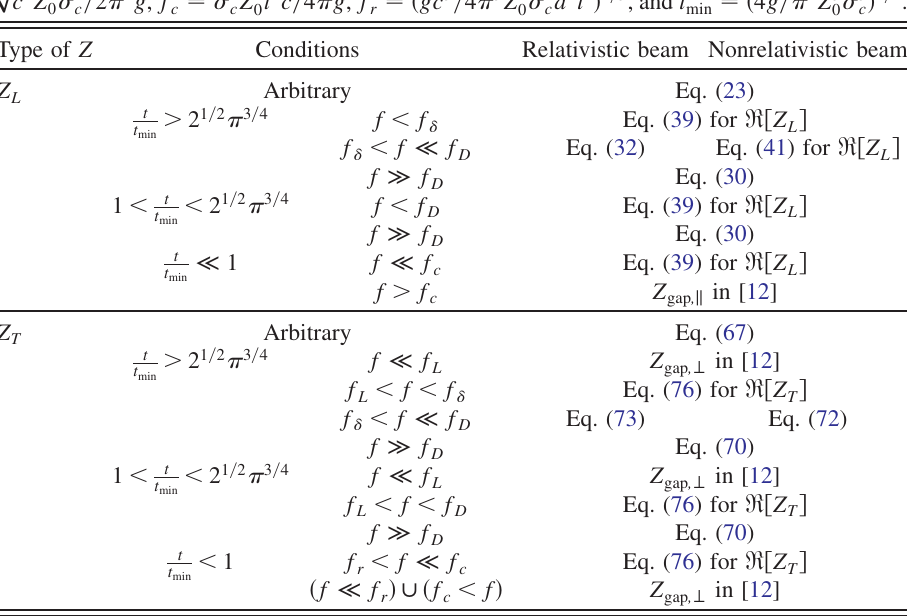
TABLE I. Valid formulas categorized according to various cases of inserts, where a is the radius of the chamber, g is the length of the insert, t is the thickness of the insert, c is the velocity ð¼ 120 (cid:5) Þ is the impedance of free space, (cid:1) of light, Z ffiffiffiffiffiffiffiffiffiffiffiffiffiffiffiffiffiffiffiffiffiffiffi p 0 Þ is the skin depth, f c=(cid:5)Z f(cid:1) frequency, (cid:7) ð¼ ffiffiffiffiffiffiffiffiffiffiffiffiffiffiffiffiffiffiffiffiffiffiffiffiffiffiffiffiffi c 0 c 2 Z (cid:1) = 2 (cid:5) 2 c 0